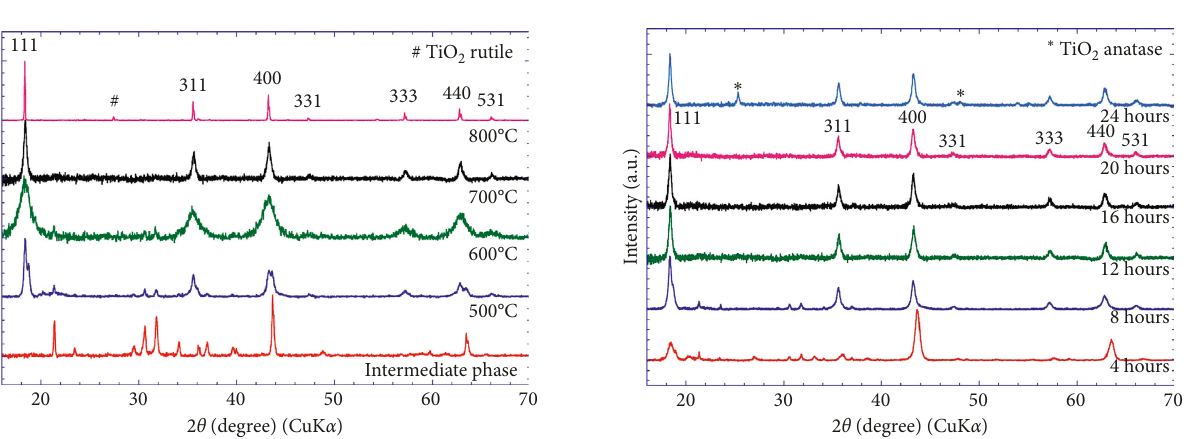
Figure 2: XRD patterns of samples at different calcination times at 700 ° C.